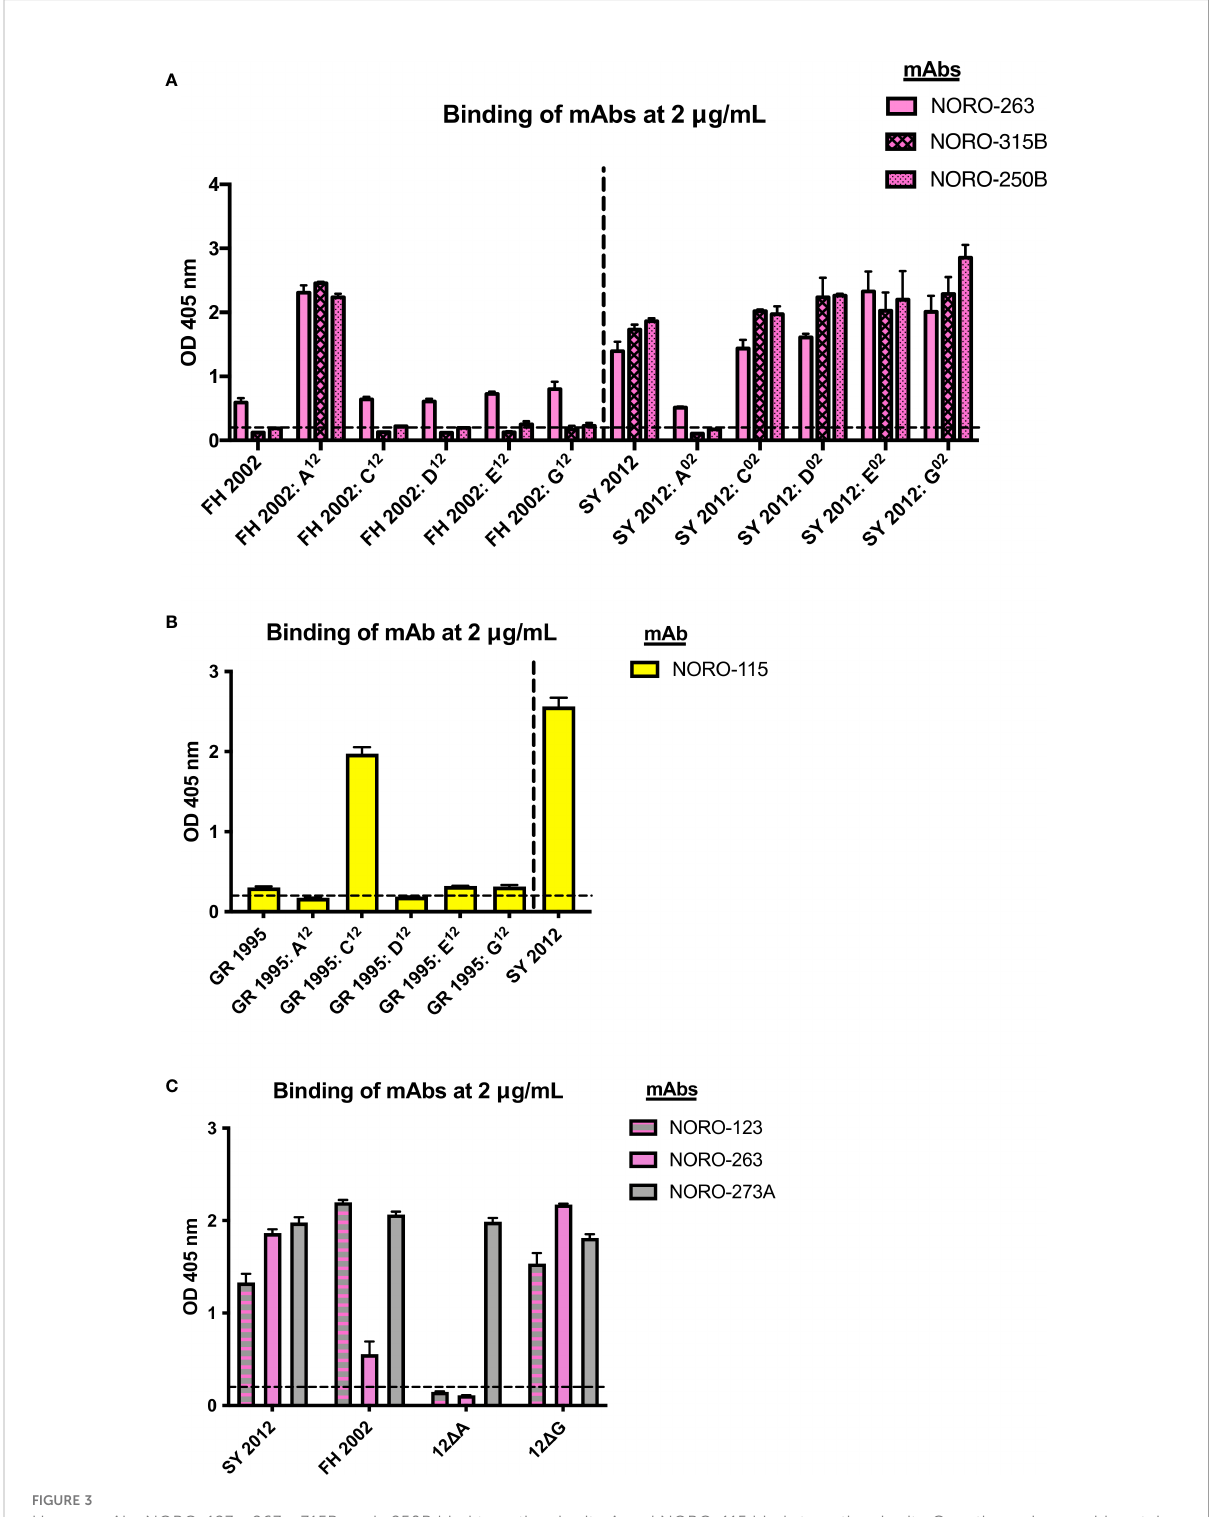
FIGURE 3 Human mAbs NORO-123, -263, -315B, and -250B bind to antigenic site A and NORO-115 binds to antigenic site C on the major capsid protein. (A) Binding of mAbs NORO-263, -315B, and -250B to wild-type (wt) VLPs from Farmington Hills (FH 2002) and Sydney (SY 2012) variants, or to mutant VLPs with swapped antigenic sites A, C, D, E, and G. (B) Binding of NORO-115 to wt VLPs from Grimsby (GR 1995) and SY 2012 variants, or to mutant VLPs with antigenic sites A, C, D, E, and G derived from the SY 2012 variant. (C) Binding of NORO-123 to SY 2012 VLPs presenting depleted antigenic sites A or G. Values represent the average binding at 2 mg/mL of each mAb. Each bar represents an average of duplicate wells. The dashed line represents the cut-off value (OD 405 nm = 0.2). The error bars represent the standard deviation of the